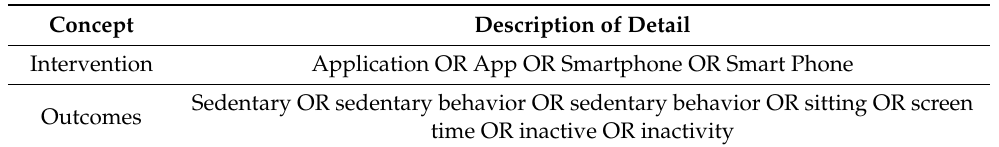
Table 2. Major search